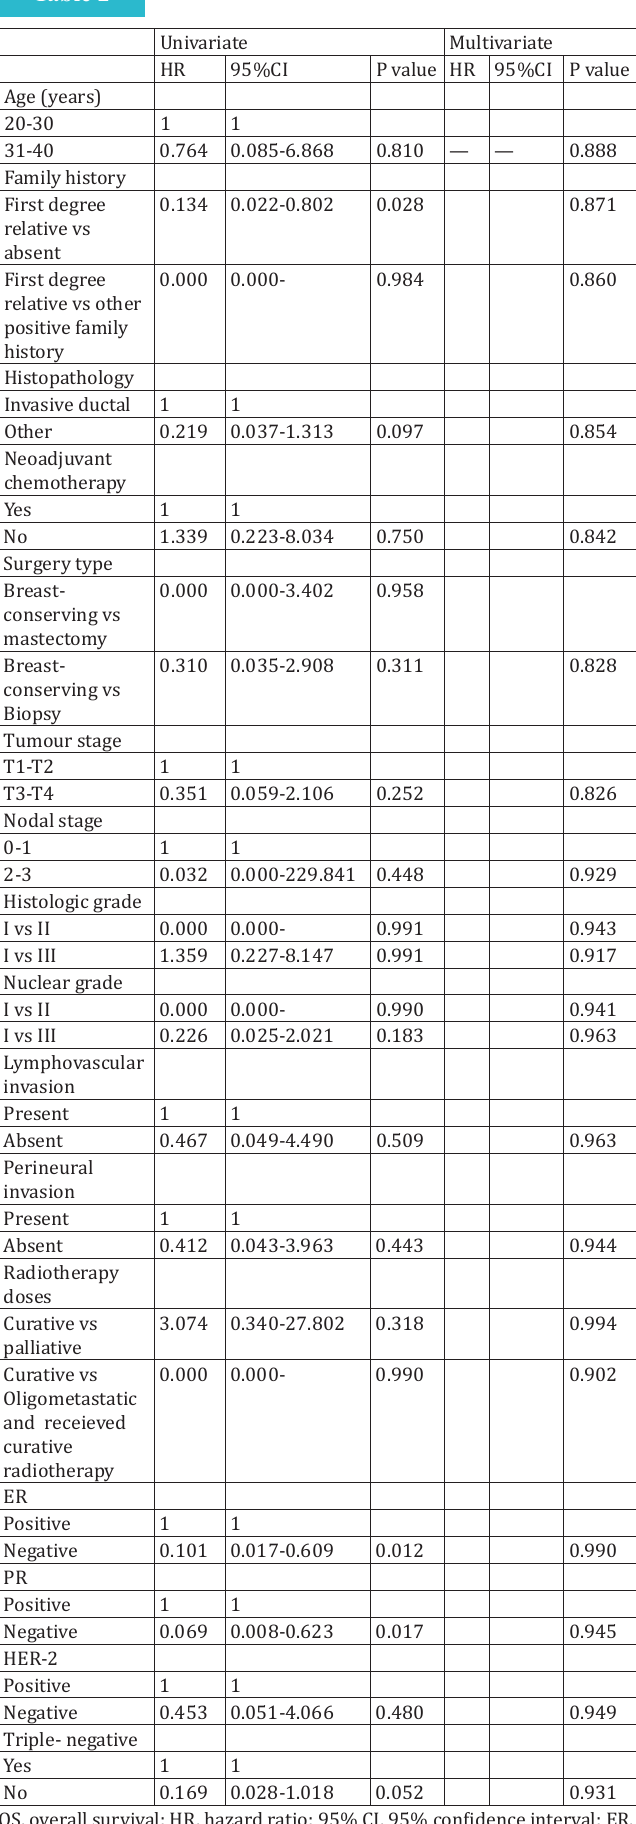
Univariate and multivariate for